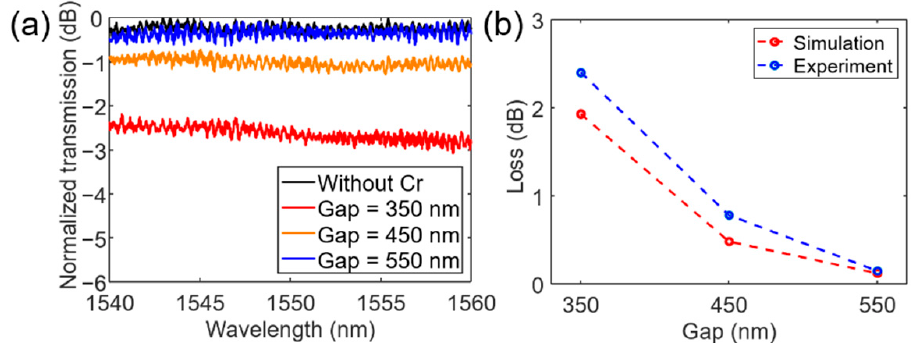
Figure 2. ( a ) Measured transmission spectra of reference rib waveguide and phase shifters with dif- ferent gaps. ( b ) Measured (blue circle) and simulated (red circle) insertion losses for different gaps.